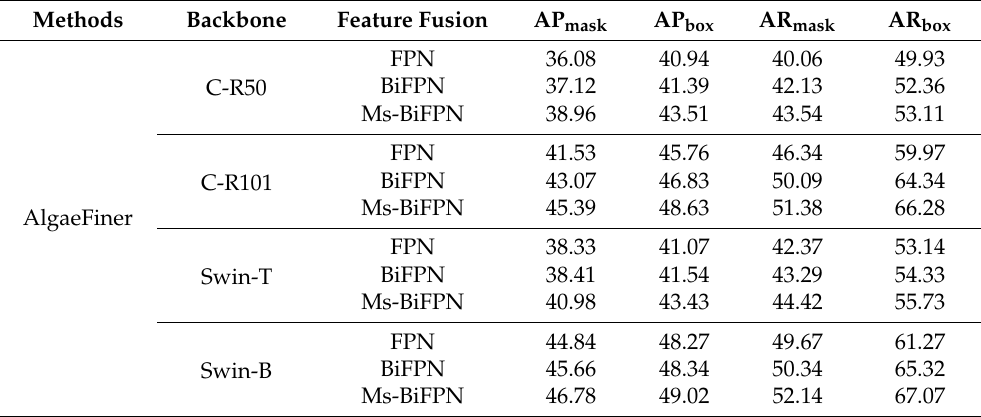
Table 9. The comparison of AP mask ,AP box , AR mask , and AR box under different feature-fusion strategies. Methods